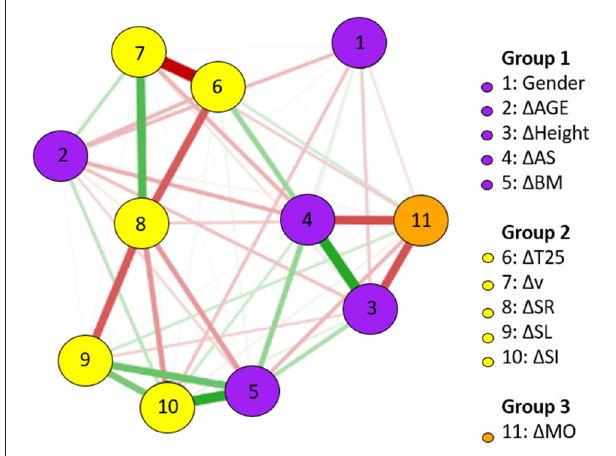
FIGURE 1 | BREAST network of association between changes ( 1 ) in anthropometrics, maturation, and kinematics (using gender as a dichotomous variable); n =